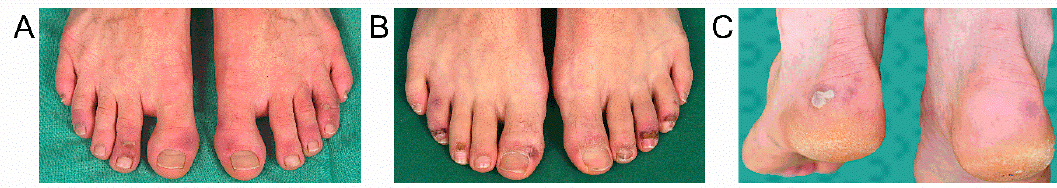
Figure 1. Clinical presentation of chilblain-like lesions on the feet and toes of three young men. Purple to red, tender chilblain-like lesions, superficial blisters and ulcerations on acral locations of the feet occurring 5 weeks after a travel through Germany in February 2020 in Patient 1 ( A ), 1 month after severe respiratory infection in Patient 2 ( B ), and 1 month after holidays in Tirol, Austria, that became a hotspot for COVID-19, in Patient 3 ( C ).